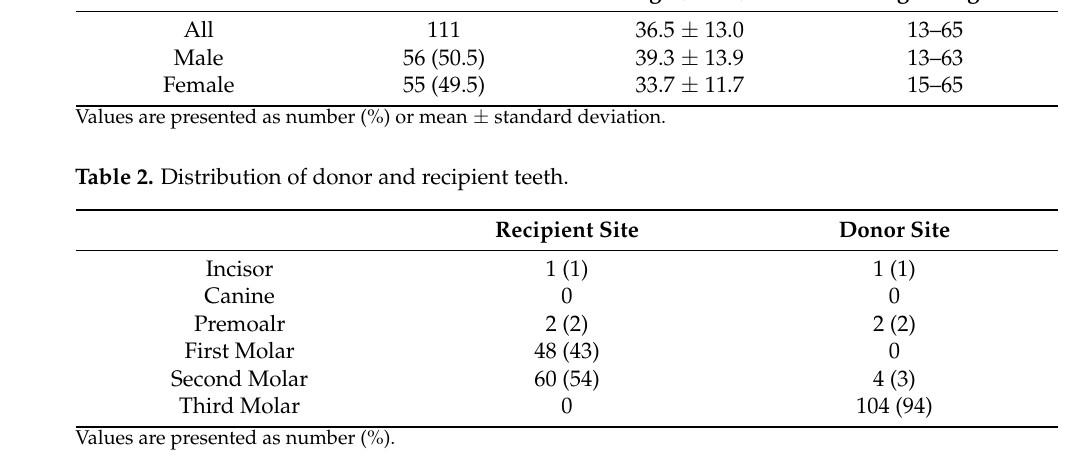
Table 1. Characteristics of patients.